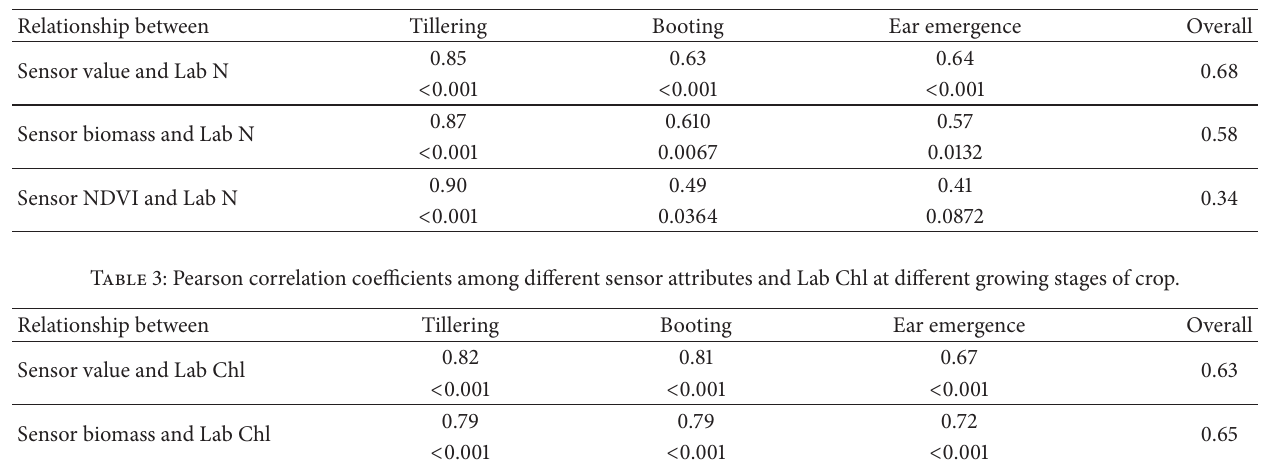
From (1), 𝑋 1 = 2.831 m and 𝑋 2 = 4.143 m, 𝑦 = 𝑋 2 −𝑋 1 =